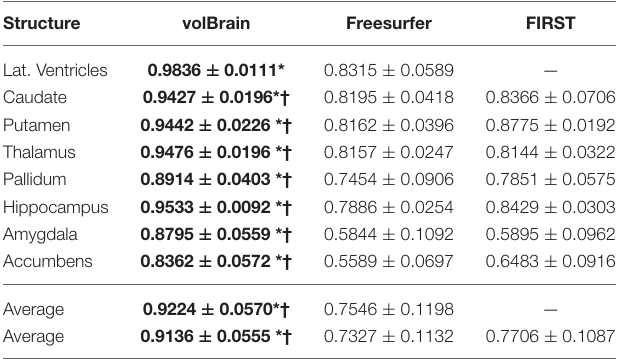
TABLE 1 | Mean Dice coefficient of the different subcortical structures over the 50 cases of template library. Structure volBrain Freesurfer